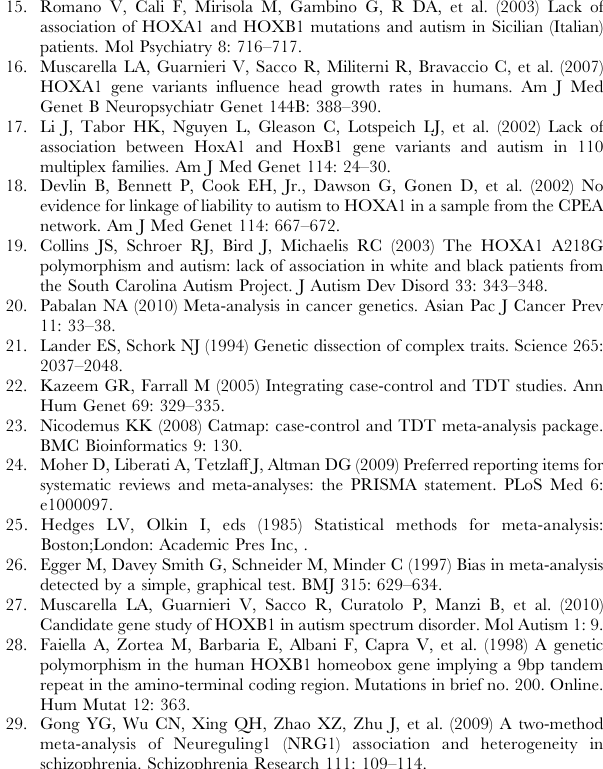
Table S1 PRISMA Checklist for this meta-analysis. Figure S1 The funnel plots of the HOXA1 A218G variant for ASD. Egger’s test: P =0.564.